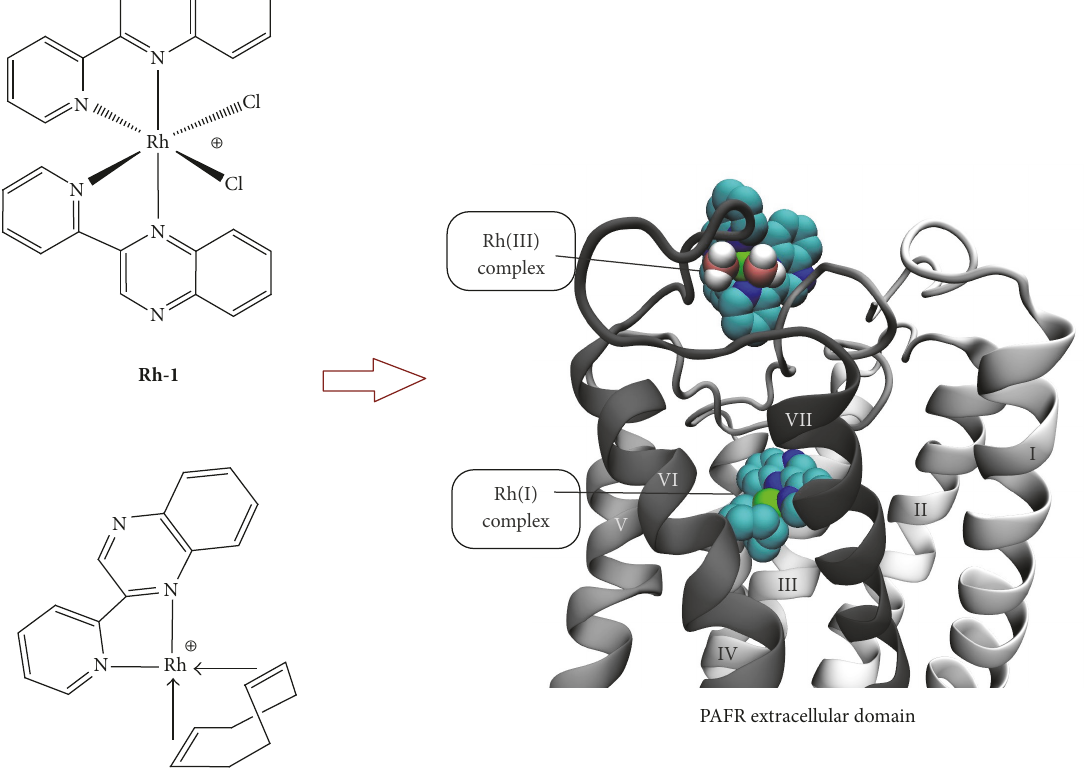
Figure 5: Molecular model of PAFR with the two predicted binding sites of the octahedral Rh(III) complex, Rh-1 , and the square planar Rh(I) complexes, Rh-5 and Rh-6 (cartoon representation).